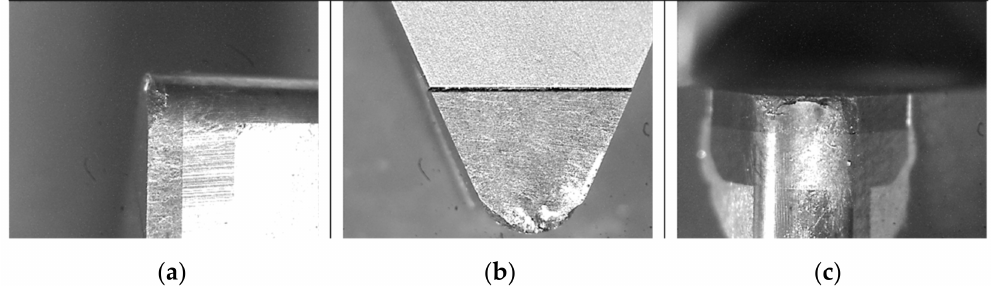
Figure 7. Sample photos of the cutting edge wear in the side ( a ), top ( b ) and front ( c ) view of the cutting insert for v c = 180 m/min (cast material).